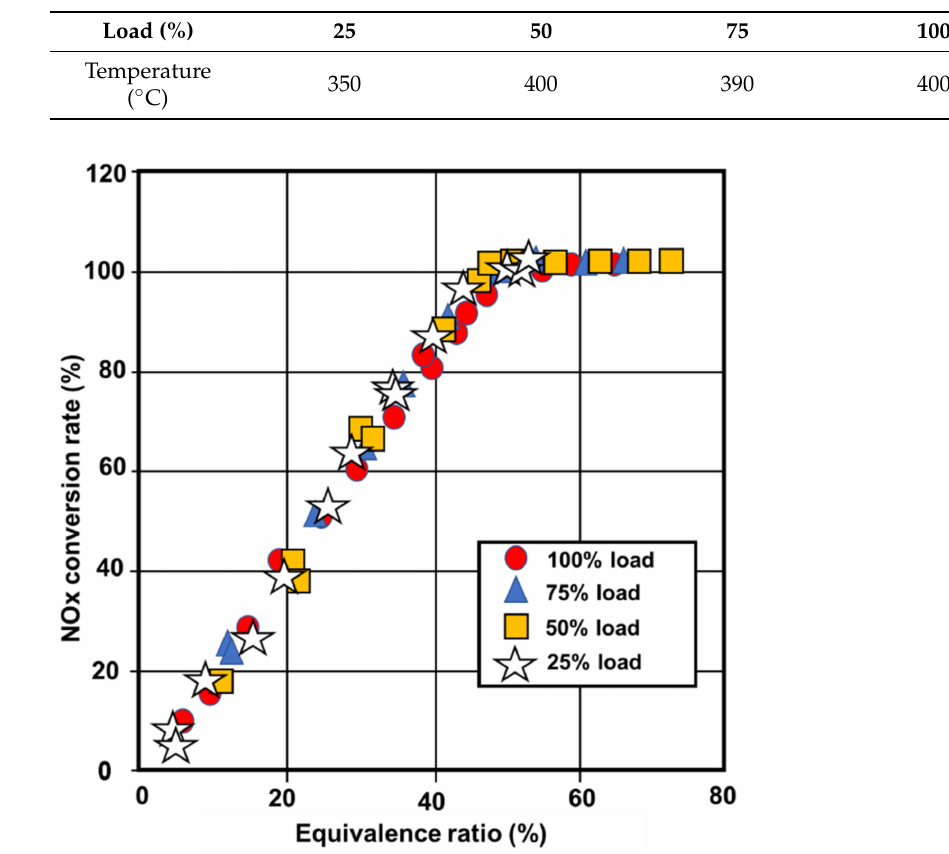
Figure 39. NOx conversion rate values against ammonia gas equivalence ratio